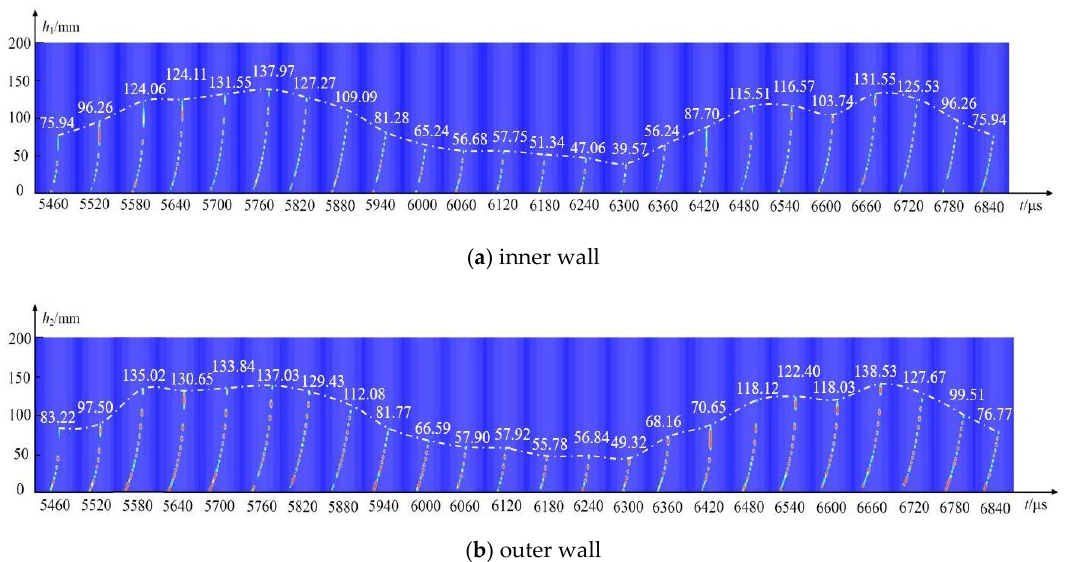
Figure 10. Changing of detonation wave height near ( a ) inner wall and ( b ) outer walls. Table 3. Time-averaged detonation wave height of RDC with different diverging nozzle. θ 0° 15° 30° 45° h d /mm 106.68 105.23 105.02